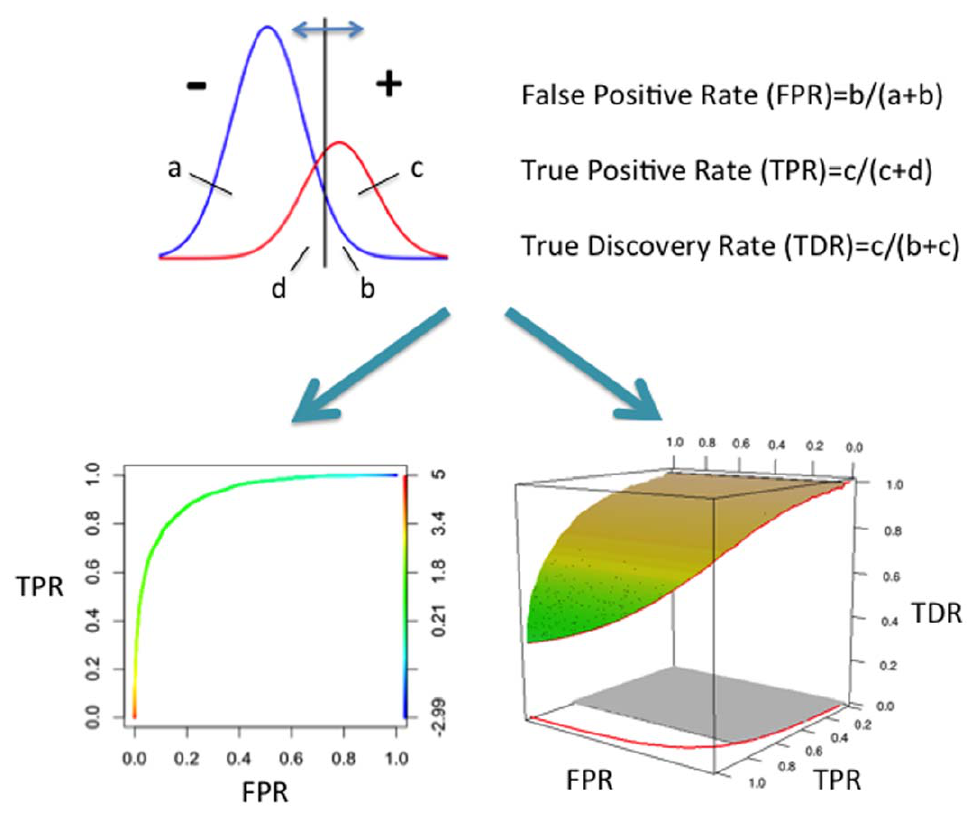
Figure 1. Illustration of the construction of the ROC curve and the ROC surface (ROCS).